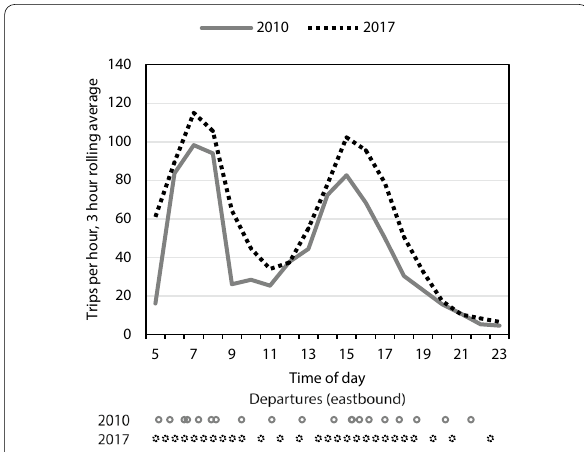
Fig. 8 Centred three‑hour rolling averages of trips per hour on the bus service between Trelleborg and Ystad (case D) on a typical weekday in 2010 and 2017. The circles below the chart represent departure times. Some departures in 2010 were very close to each other and thus are difficult to distinguish in the figure